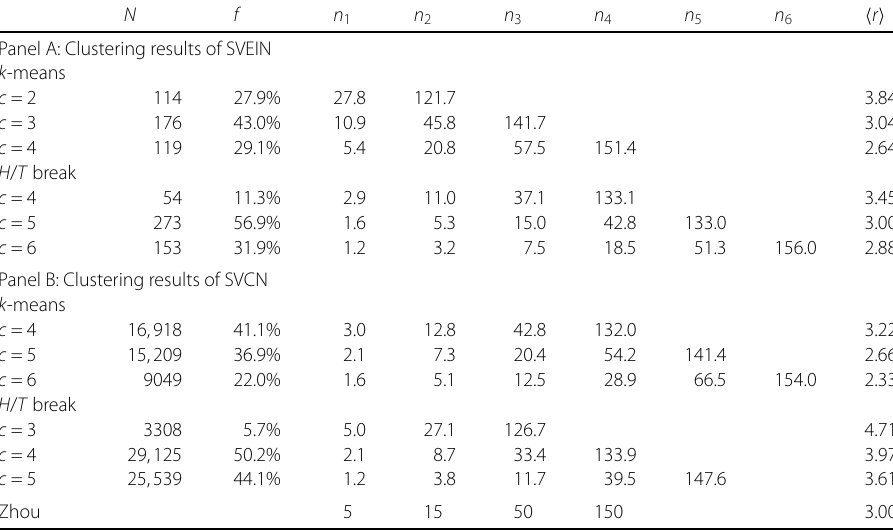
Table 3 Comparison of the clustering results for the users with degree k > 100 based on the k -mean and H / T break algorithm for the SVEIN and SVCN. N and f represents the total number and the percentage of users. n k stands for the cumulative number of users in the k -th layer. (cid:6) r (cid:7) is the average scale ratio N f n 1 n 2 n 3 n 4 n 5 n 6 (cid:6) r (cid:7) Panel A: Clustering results of SVEIN k -means c = 2